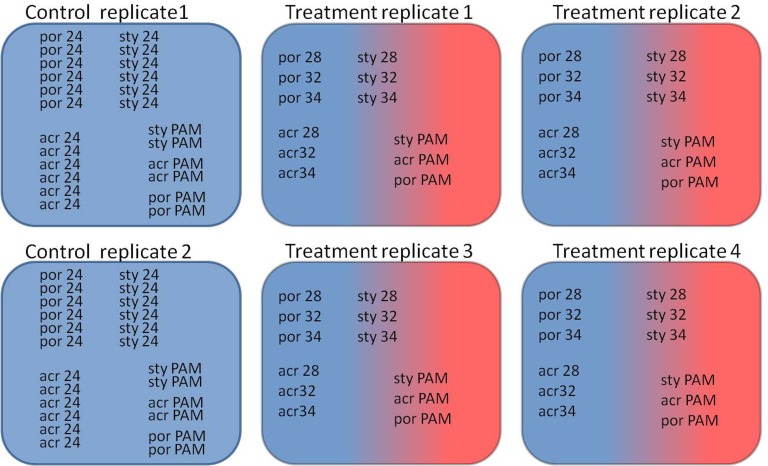
Experimental design of the experiment.Two control aquaria and four experimental aquaria: Coral fragments (por; Porites sp., sty; S. pistillata, acr; A. eurystoma) were sampled at the time points corresponding to 24 h incubation at the following temperatures (28, 32 and 34; 28 °C, 32 °C and 34 °C) and concurrent PAM measurements of fragments was used for evaluating the maximum quantum yield (PAM; fragments used for evaluating the maximum quantum yield).